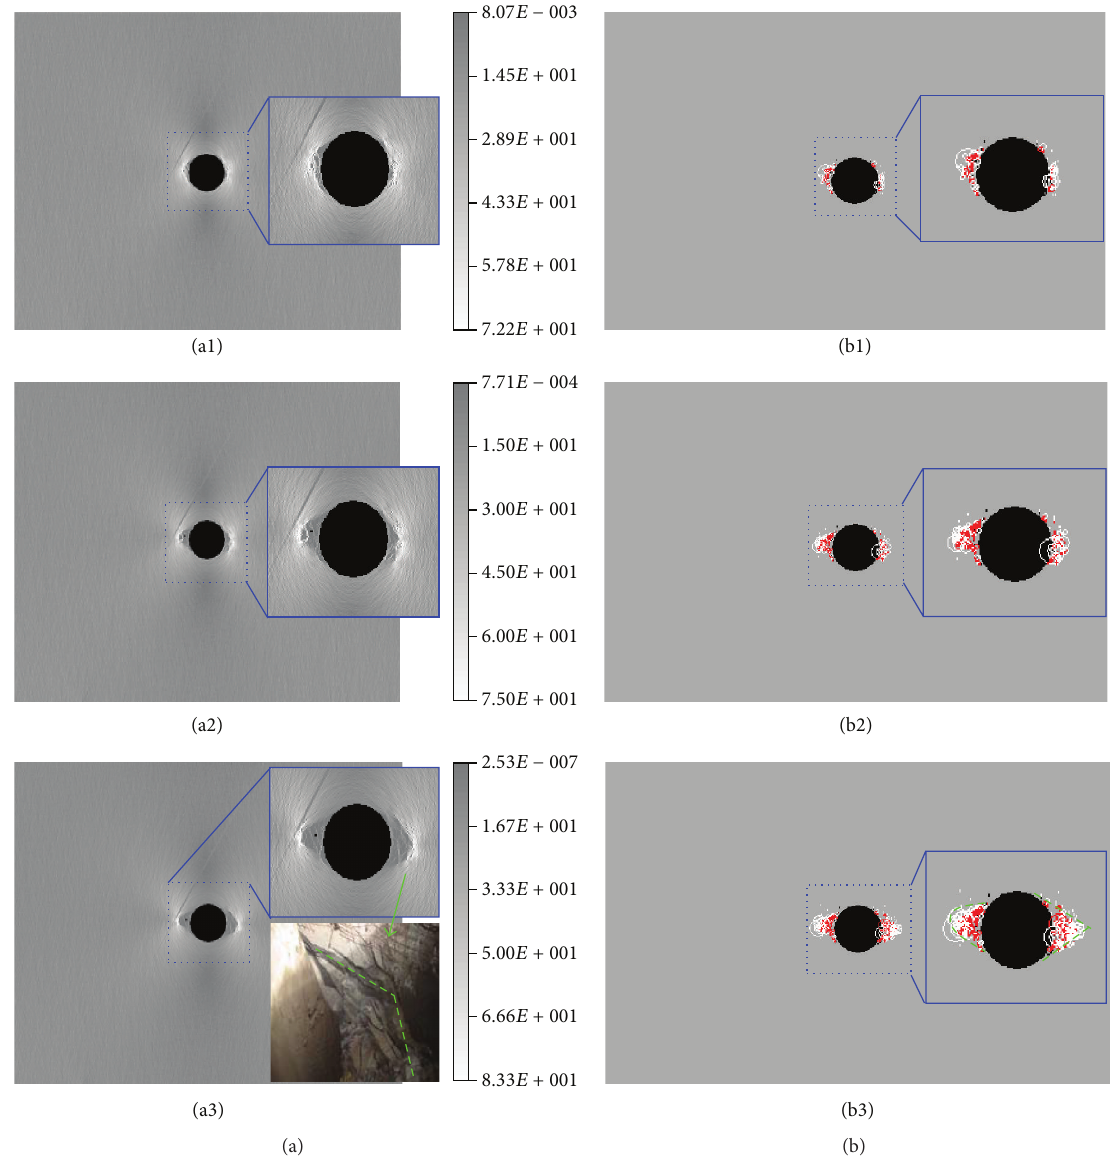
Figure 13: Shear stress and acoustic emissions during surrounding rock failure in an underground cavern. (a) Variation in the shear stress during crater formation and (b) acoustic emission distribution during crater